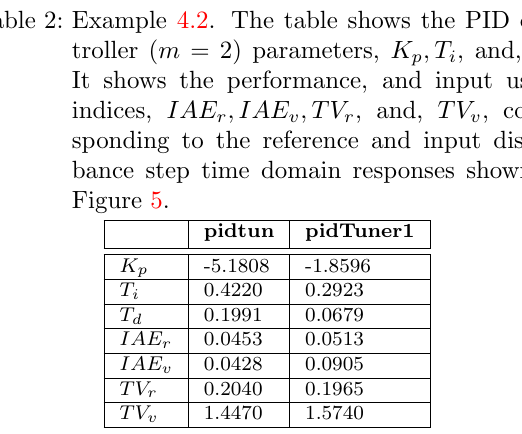
ing pidtun (Algorithm 1) and pidTuner1 (Algorithm 2), where both methods are used with default param- eters, except that the ”speed of response”, ζ = 2 , and, gain crossover frequency, ω c = 0 . 01 , are both used to prescribe the sensitivity function peak, M s = max 0 ≤ ω< ∞ | the transfer function corresponding to the (identified) deterministic SSM in Eqs. (4) and (5).